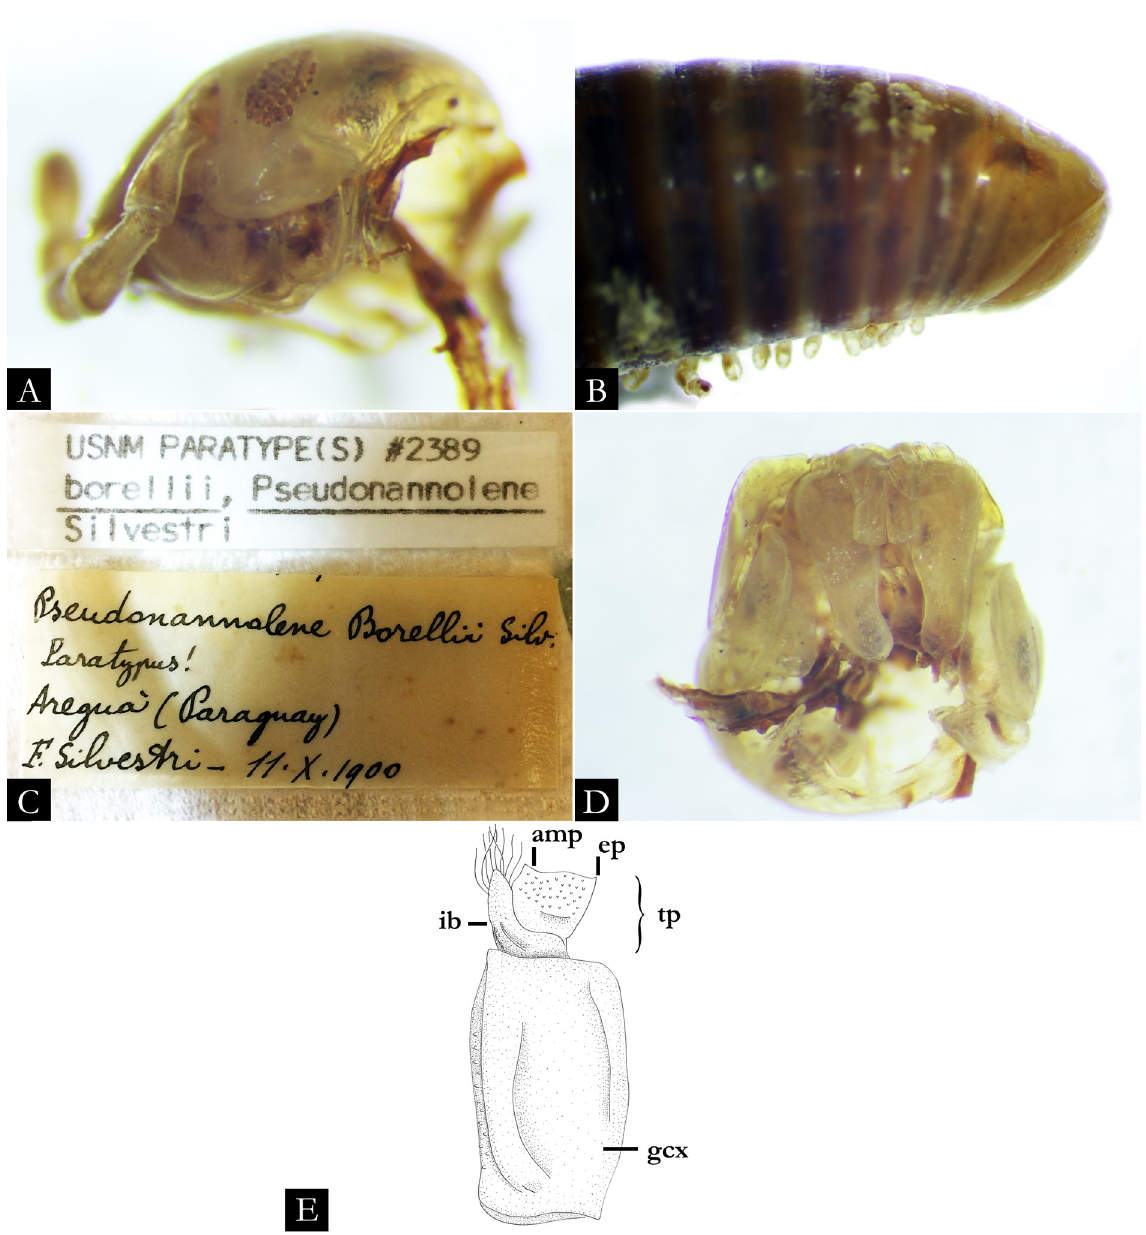
Fig. 50. Pseudonannolene borelli Silvestri, 1895, topotype, ♀ (USNM 2389). A . Head in lateral view. B . Posterior region. C . Original label of topotype (erroneously labeled as paratype by F. Silvestri). D . Gnathochilarium in ventral view. E . Schematic drawing of left gonopod in anal view (modified from Silvestri 1895b: fig. 12). Abbreviations: see Material and methods. Images not to